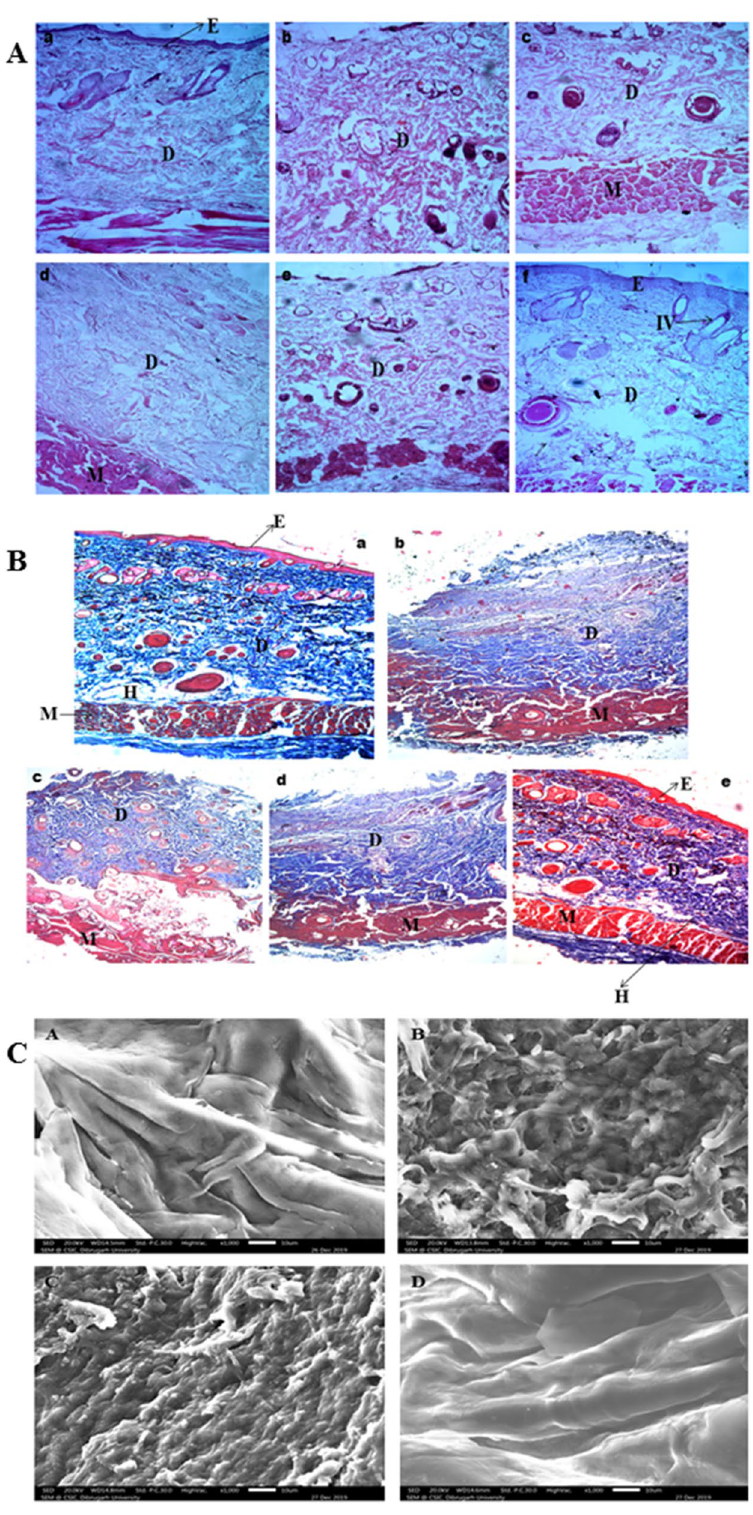
Figure 2. ( A ) Histopathology of different treated groups; (a) normal skin of rat, (b) untreated burned skin, (c) Rat skin of standard group on 8th day and (d) on 16th day, (e) BOF treated skin on 8th day and (f) on 16th day by using HE stain. ( B ) Histopathology of different treated groups; a) normal skin of rat, (b) untreated burned skin, (c) Rat skin of standard group on 16th day, (d) BOF treated skin on 8th day and (e) on 16th day by using MT stain. ( C ) Scanning electron microscopy of skin tissue of Wistar rats; (A) normal skin of rat, (B) untreated burned skin, (C) standard group, (D) BOF